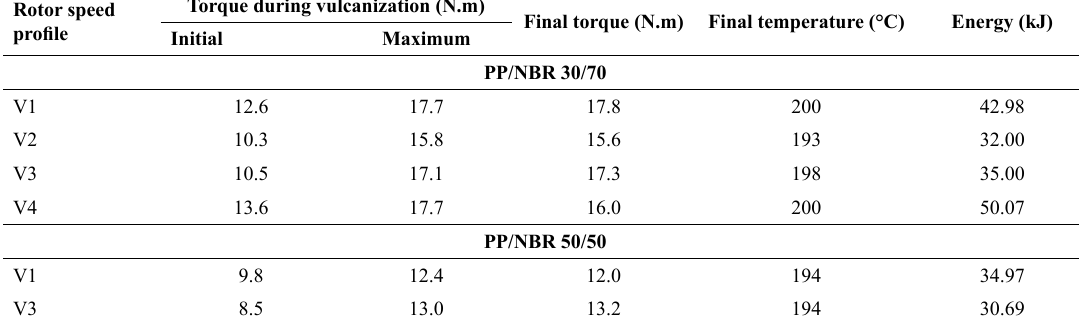
Table 2. Processing parameters supplied by torque rheometer as a function of the rotor speed. Rotor speed